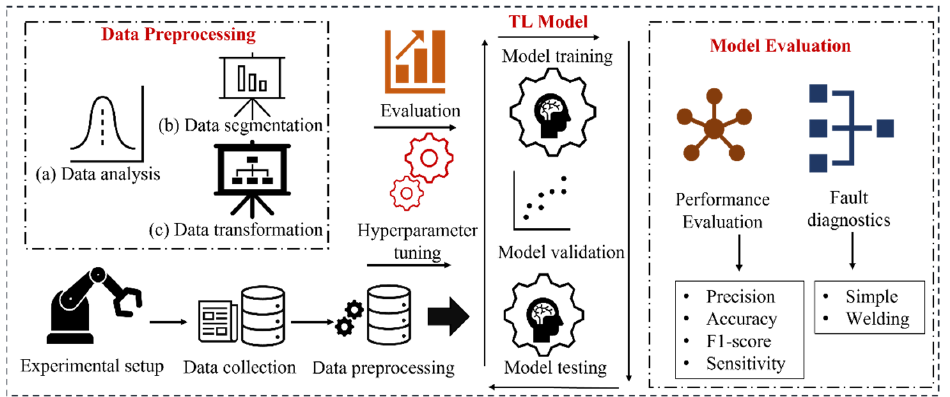
Figure 1. Proposed research methodology for the robotic FDD.